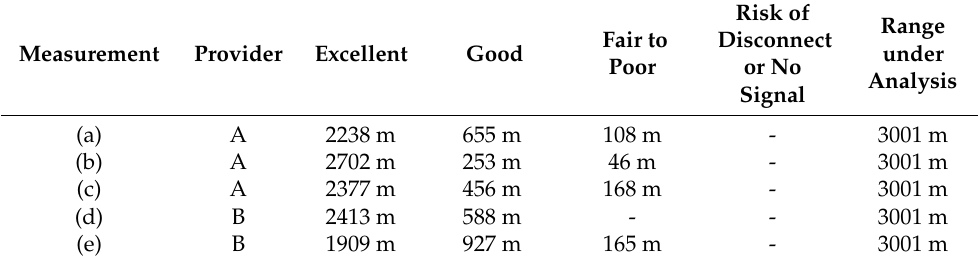
Table 10. Provider based assessment